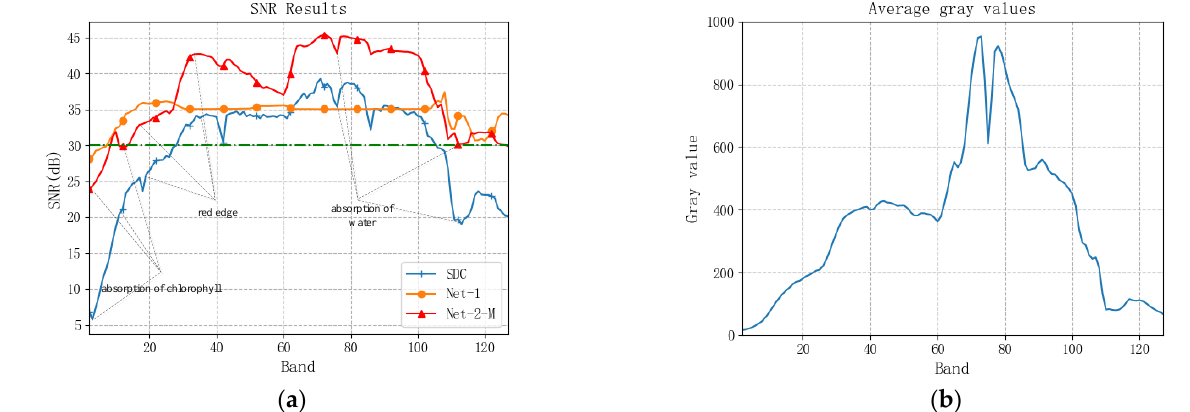
Figure 9. The SNR results estimated on the hyperspectral imagery by SDC, Net-1, and Net-2-M. The green dash line represents the SNRs calibrated in laboratory (most of SNRs >30 dB and were 40 dB on average). The figure also shows the absorption and reflection of solar spectrum by green vegetation: spectral absorption of chlorophyll at the wavelength 450 nm and 650 nm (band 4 and 12); “red edge” near 700–950 nm (band 16–36); spectral absorption of water in plant tissue at 1450 nm and 1900 nm (band 76 and 112). ( a ) The SNR results estimated by three methods; ( b ) The average gray value of each band.